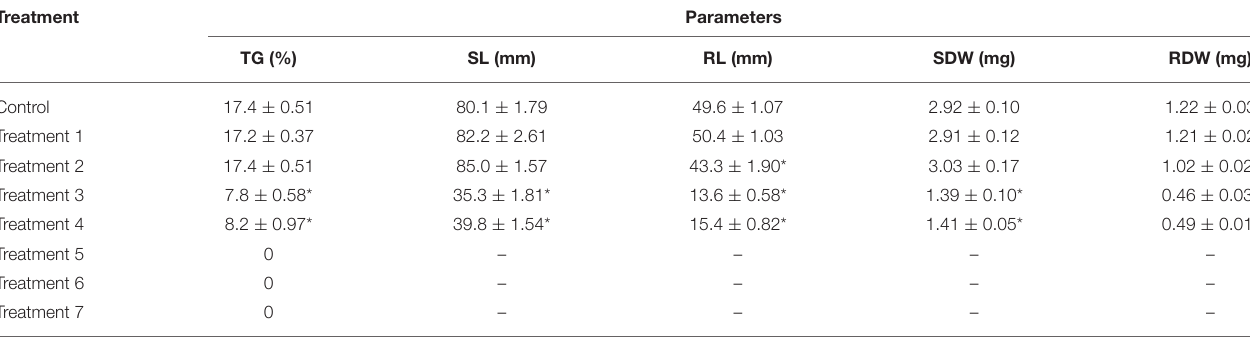
TABLE 1 | Effects of boneseed extract, herbicide, and mixtures on pre-emergent ryegrass. Data was collected at 19 days after sowing and presented as average ± SE.